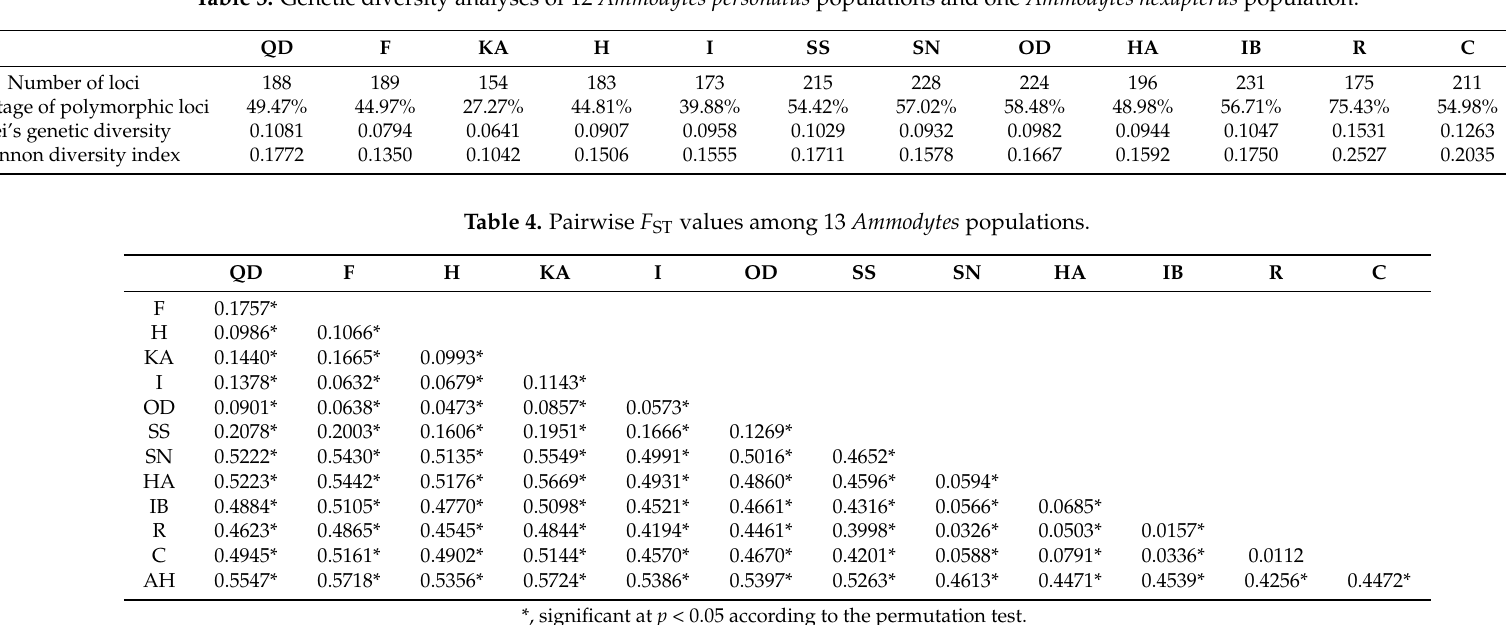
Table 3. Genetic diversity analyses of 12 Ammodytes personatus populations and one Ammodytes hexapterus population.